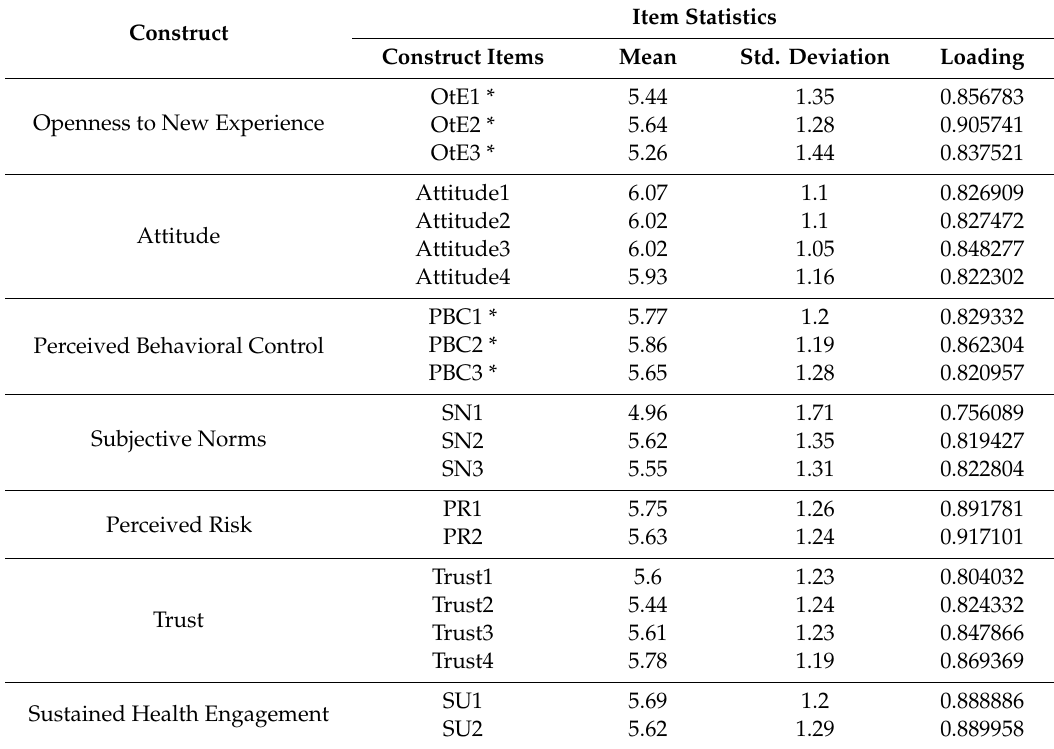
Table 1. Reliability analysis of